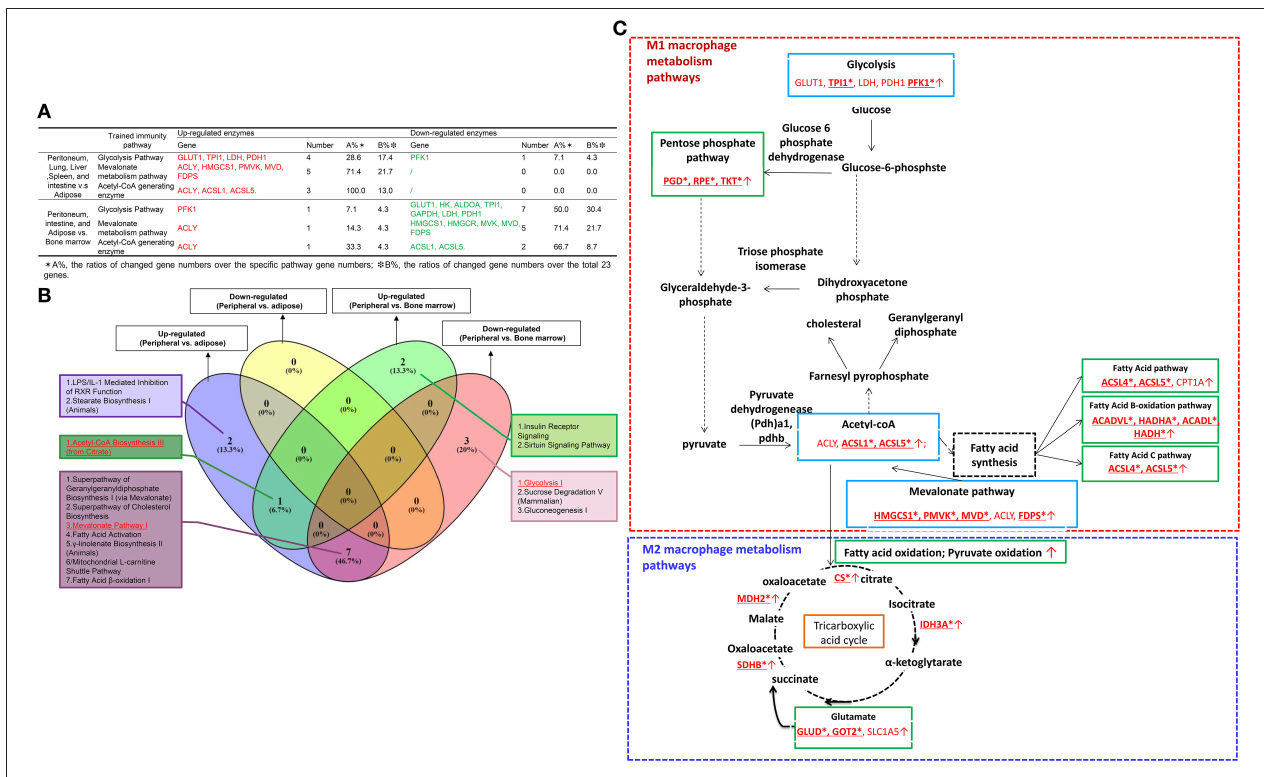
FIGURE 6 | (A) Mechanism VI: The macrophages from peritoneum, lung, liver, and spleen upregulate more trained immunity (innate immune memory)-related metabolic genes than that of adipose tissues, and the macrophages from peritoneum, small intestine, and adipose tissues upregulate more trained immunity-related metabolic genes than bone marrow macrophages (For detailed expression data, see Figure S8 ). (B) Ingenuity pathway–Venn Diagram analyses show that the macrophages (M ϕ ) from peritoneum, lung, liver, spleen, and intestine upregulate more shared trained immunity regulators such as mevalonate pathway regulators than M ϕ from bone marrow. (C) The expression changes of 19 new enzymes involved in intracellular immunometabolism pathways (IMPs) and trained immunity pathways (TIPs) of M1 M ϕ and 6 new enzymes involved in IMPs and TIPs of M2 M ϕ may be the mechanisms underlying the higher M1 M ϕ proinflammatory status of lung, liver, spleen, and intestine and the disease group-specific pathways and shared disease pathways (PMIDs:28381829; 27396447;26694790; 30679807; 28396078). The green boxes are bioenergetics pathways ( Figure 5A ), and the blue boxes are trained immunity pathways (A) . SLC1A5, GLUT1, LDH, PDH, ACLY, and CPT1A are mentioned in previous studies. However, IDH is found to decrease in M1, but not sure in M2. *25 others (bolded and underlined) are not found in the reviews listed